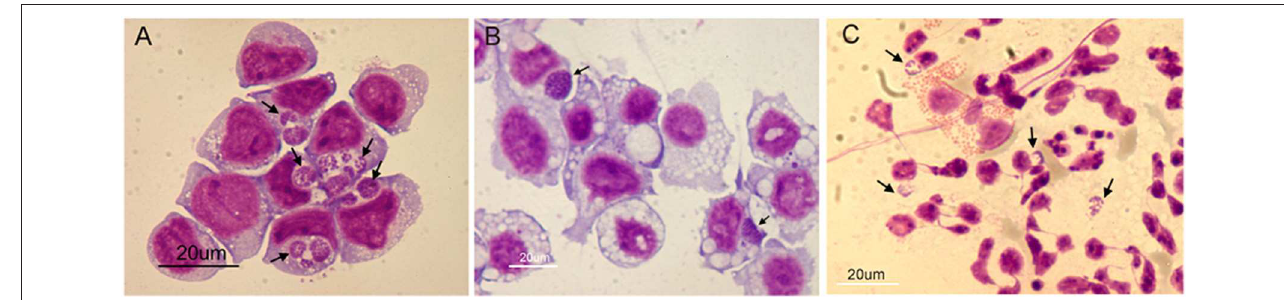
FIGURE 5 | Light microscopy images of Giemsa-stained cells used for transcriptome analysis of A. phagocytophilum (Ap) replicating in three cell types. Panel (A) HL-60 cells infected 24h, (B) ISE6 cells infected 48h, and (C) human granulocytes infected 24h. Arrows indicate morulae (Ap colonies within vacuoles). Cytospin slides of each sample were air dried, fixed in methanol and Giemsa-stained. Scale bars = 20 µ m.